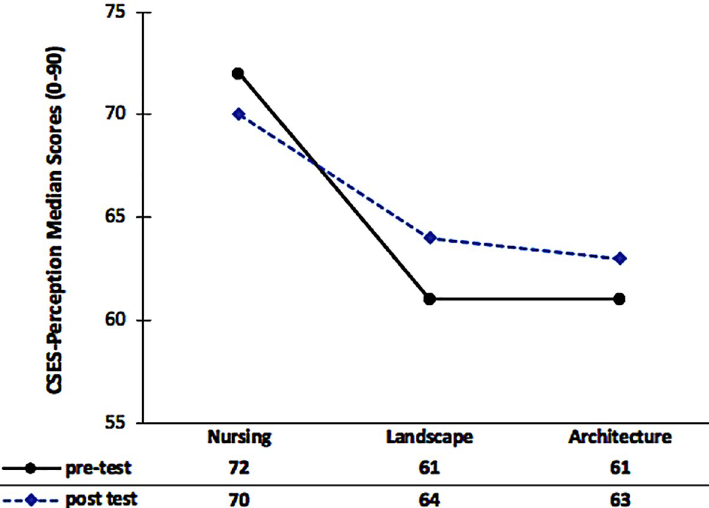
Fig 2. CSES-Perception median scores in each measurement session across the three study groups (nursing, landscape, architecture).